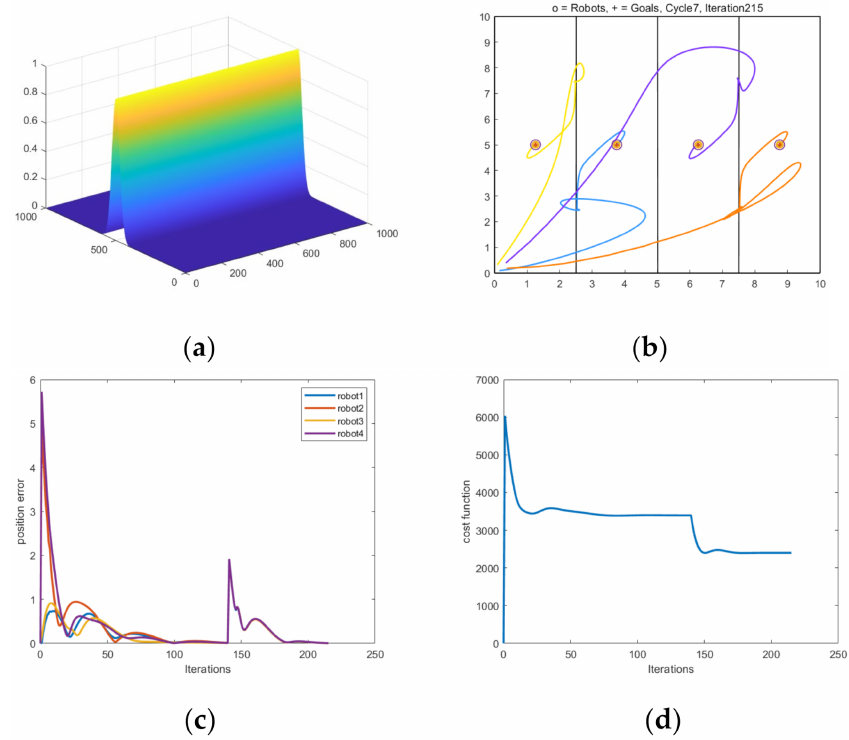
Figure 7. Multi-robot linear formation simulation: ( a ) density function distribution; ( b ) linear formation; ( c ) position error; ( d ) cost